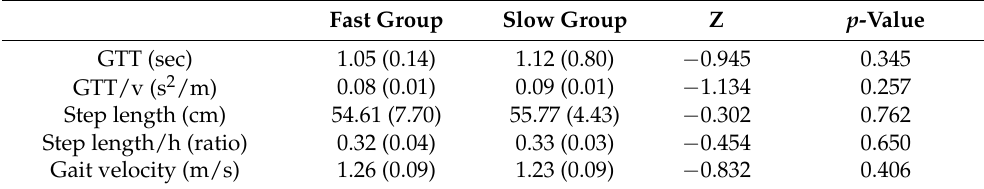
Table 3. Comparison of spatiotemporal parameters during the unplanned gait termination between the